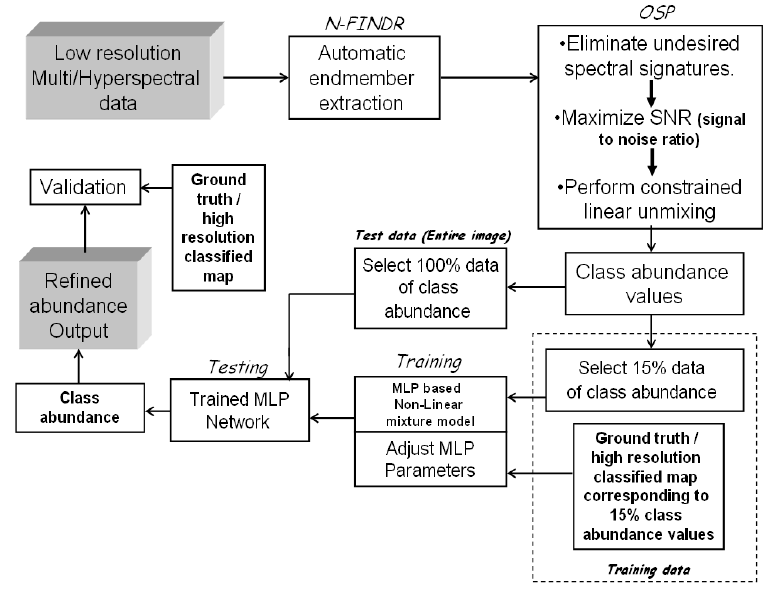
Figure 2. Hybrid mixture model (HMM) method for spectral mixture